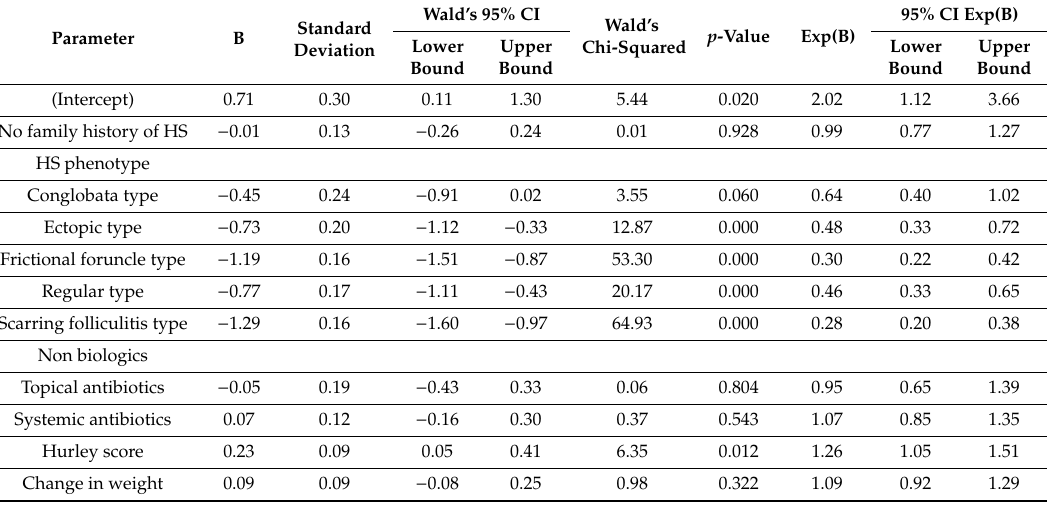
Table 4. Multivariate log-linear robust Poisson regression analysis shedding light on the determinants of change in draining tunnels before, during and after the month of